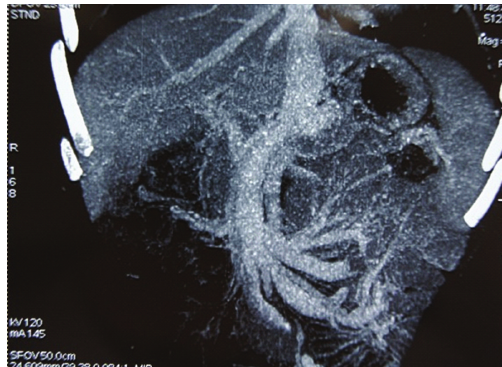
Figure 4: CTA reveals that intestinal and splenic venous blood bypassed the liver and drains into the inferior vena